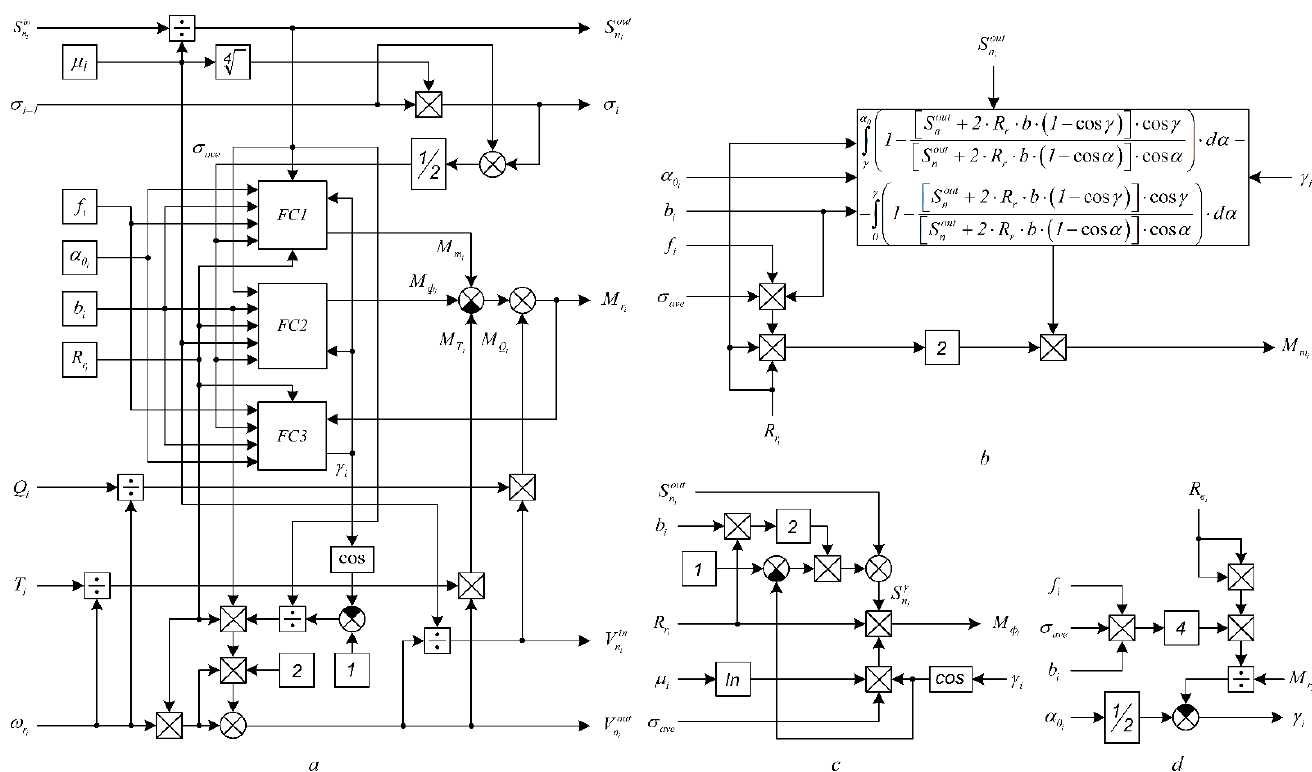
Figure 6. Functional layout of the mathematical model of the rolling stand deformation zone: ( a ) general diagram; and ( b – d ) diagrams of functional converters FC1 , FC2 and FC3 , respectively.